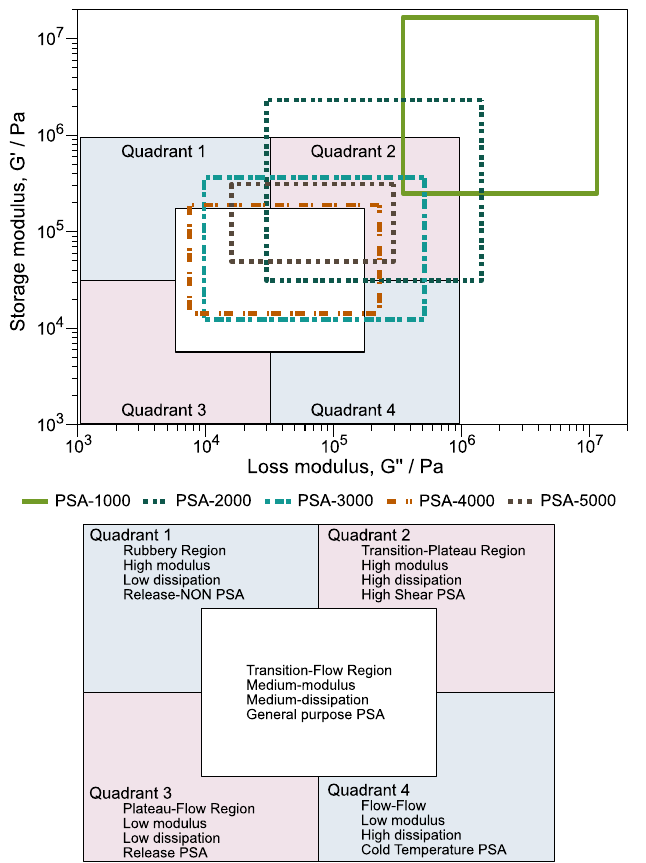
Figure 8. Evaluation of PSA-1000, PSA-2000, PSA-3000, PSA-4000, and PSA-5000 samples under the criteria of viscoelastic windows.